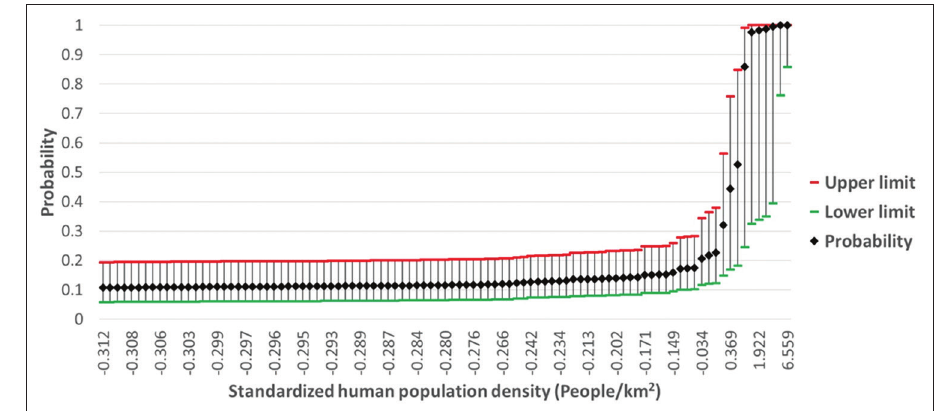
Figure-3: Association between high swine in-degree area and human population